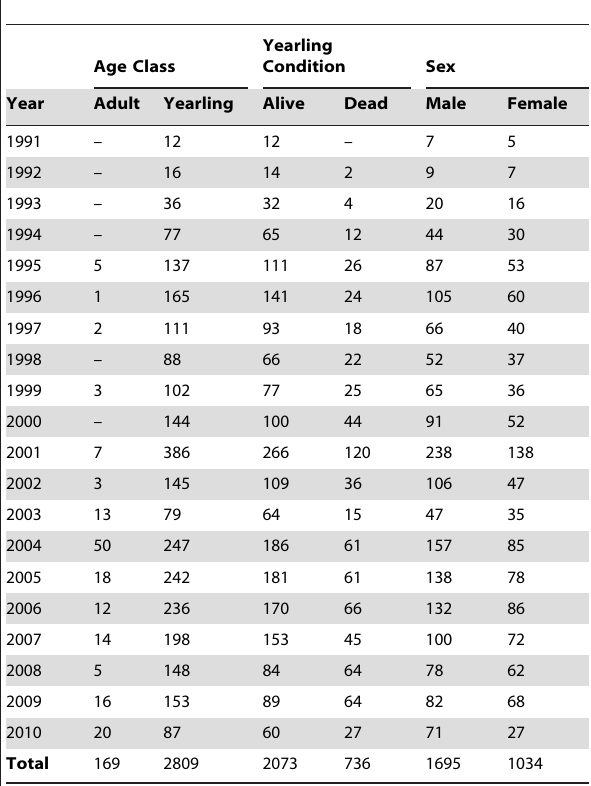
Table 2. Numbers of harp seal strandings along the eastern coast of the U.S. categorized by the demographic variables age class, yearling stranding condition, and